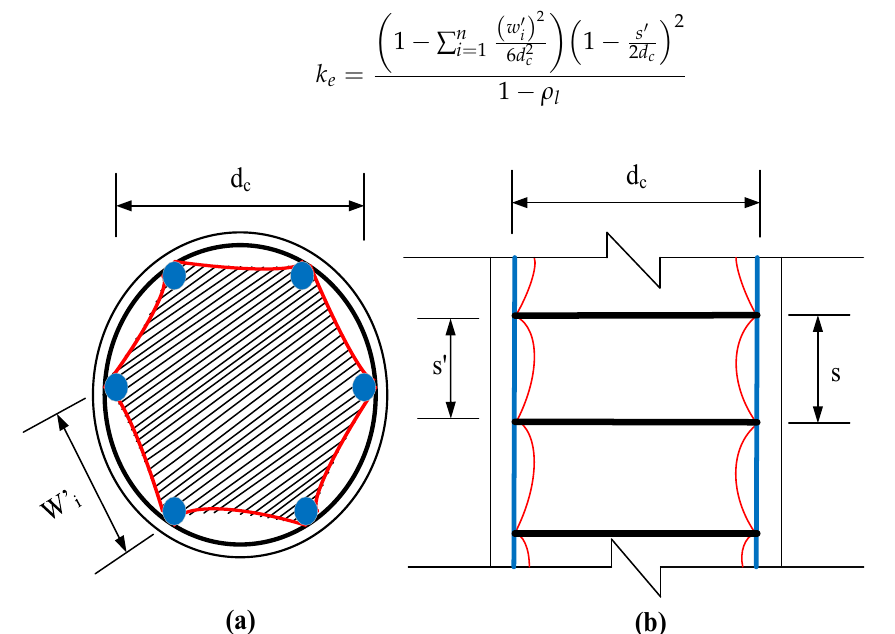
Figure 16. Effectiveness of glass-FRP confinement ( a ) cross-section ( b ) elevation of GFGC column. In this equation, w (cid:48) is the clear distance between the longitudinal glass-FRP rebars, s (cid:48) is i the distance between glass-FRP stirrups, and ρ l is the reinforcement ratio of long glass-FRP rebars in percentage. The functional transverse confining stress due to glass-FRP stirrups can be described by Equation (27) as recommended by Mander et al. [62]. The parameters f l and k e can be calculated using Equations (24) and (26), respectively. Ahmad et al. [64] and Raza et al. [65] recommended the correlations for calculating the peak stress and respective strain of concrete constrained with glass-FRP stirrups based on the empirical values given by Equations (28) and (29), respectively. where f (cid:48) is the ultimate stress of concrete constrained with glass-FRP stirrups, ε (cid:48) is cc co the unconfined concrete compressive strain respective to ultimate compressive load and ε (cid:48) is the maximum concrete compressive strain confined with glass-FRP stirrups. The cc parameters ρ k and ρ ε are the confined concrete stiffness ratio and strain ratio which can be calculated as follows, respectively: